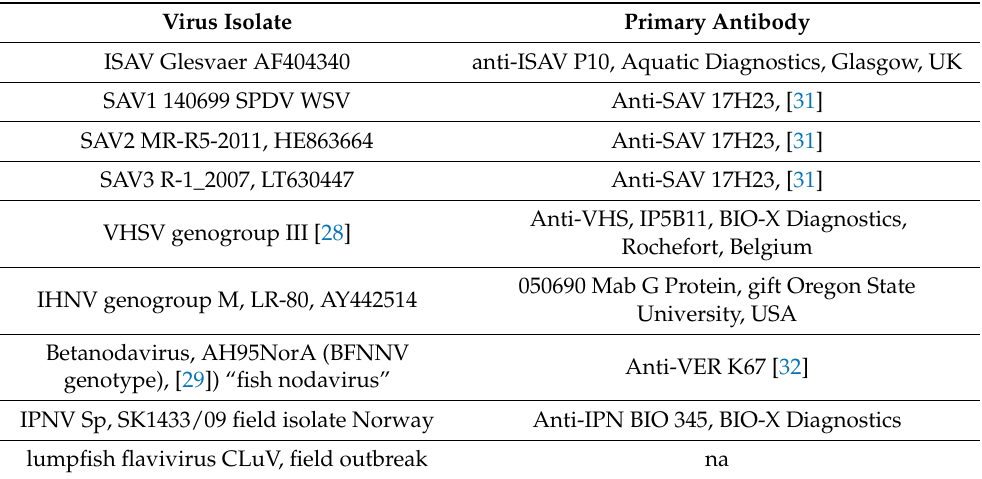
Table 2. Overview of virus isolates and primary antibodies.